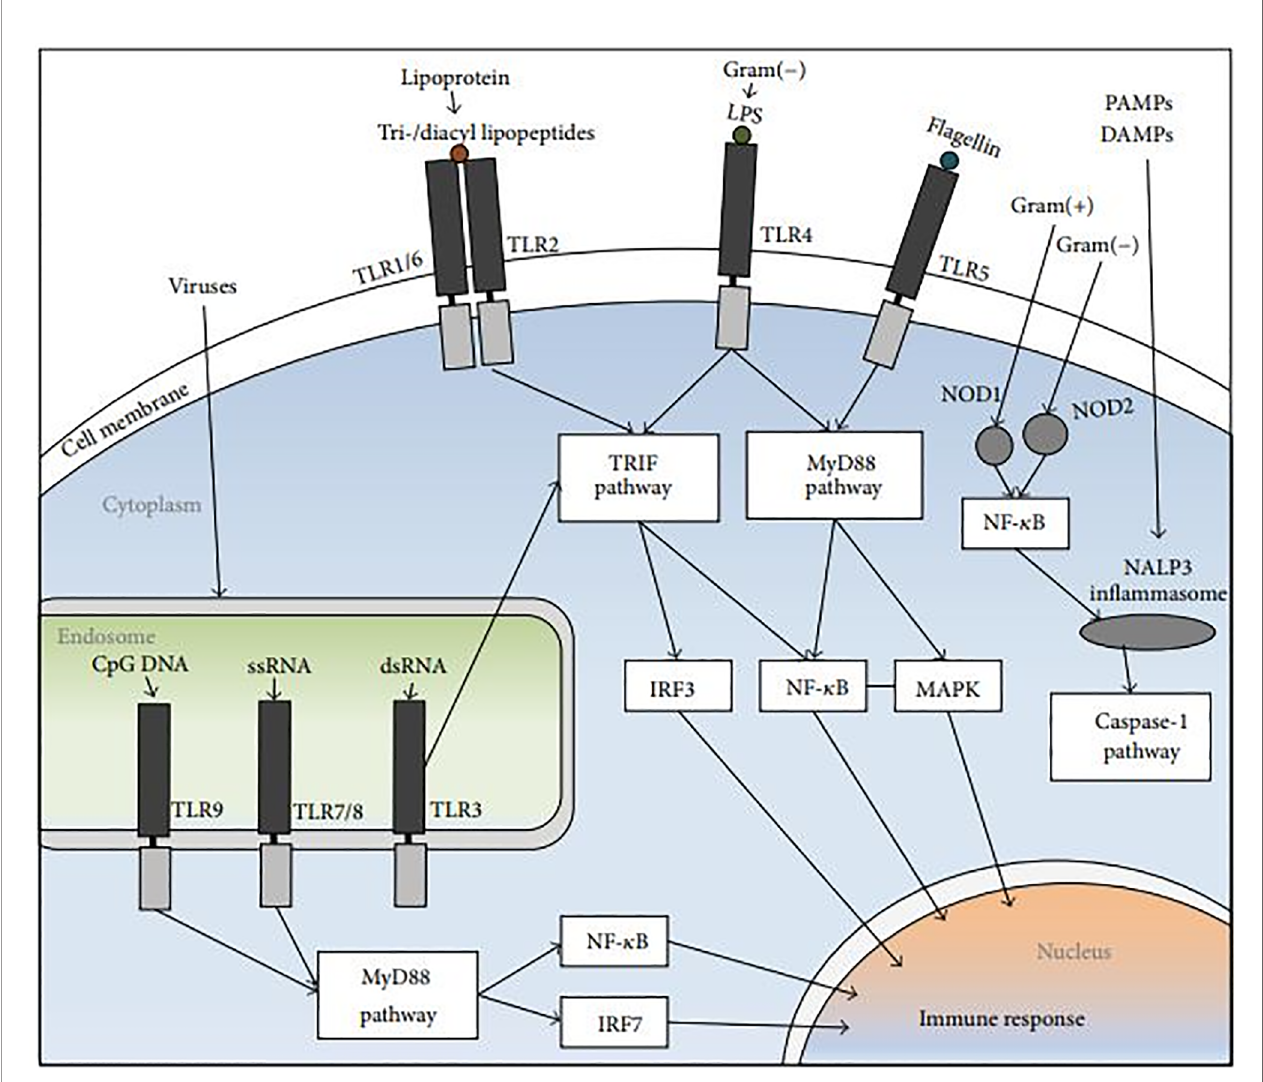
FIGURE 3 | The NLR and TLR signal-transduction pathways. The PRRs identify DAMPs and PAMPs. Endosomal TLR3, and TLR4, TLR1/6+TLR2 heterodimers stimulate the TRIF pathway, followed by NF- k B and IRF induction. The MyD88 pathway is activated by TLR5 and endosomal TLR9 and TLR7, followed by IRF7, NF- k B and MAPK activation. NOD2 and NOD1 which are cytoplasmic PRRs, induce the recruitment of NALP3 in fl ammasome, trigger the release of NF- k B, and activate the caspase-1 pathway